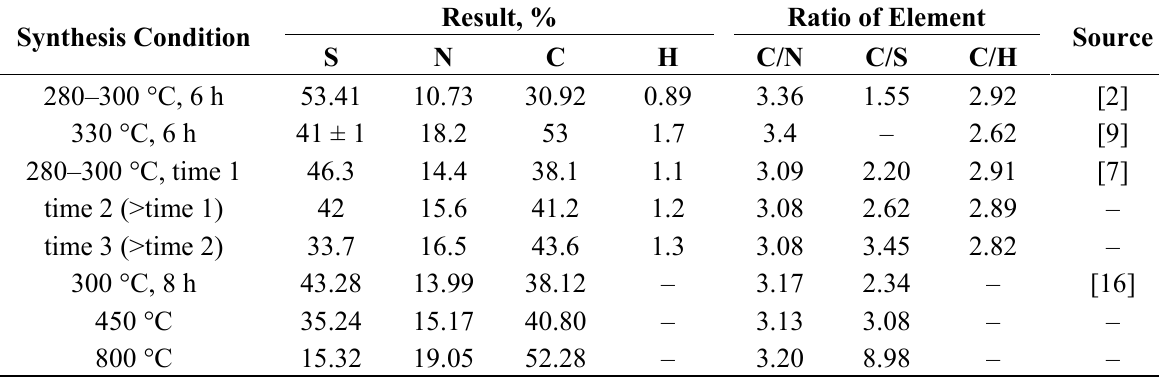
Table 1. Summary of elemental analysis results on sulfurized polyacrylonitriles (SPANs) made by different